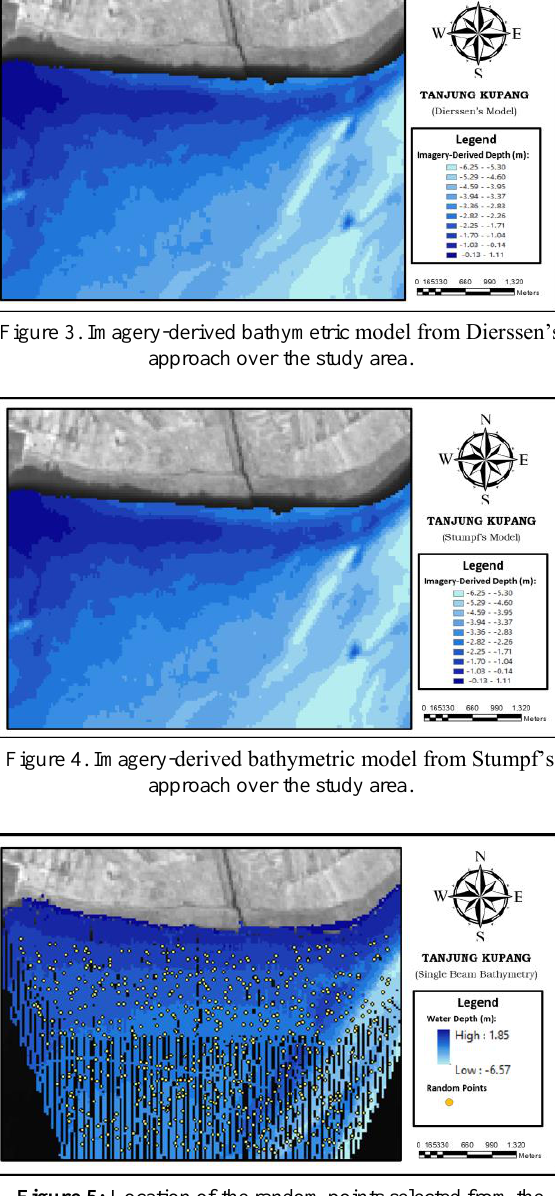
Figure 5: Location of the random points selected from the SBES data for depth